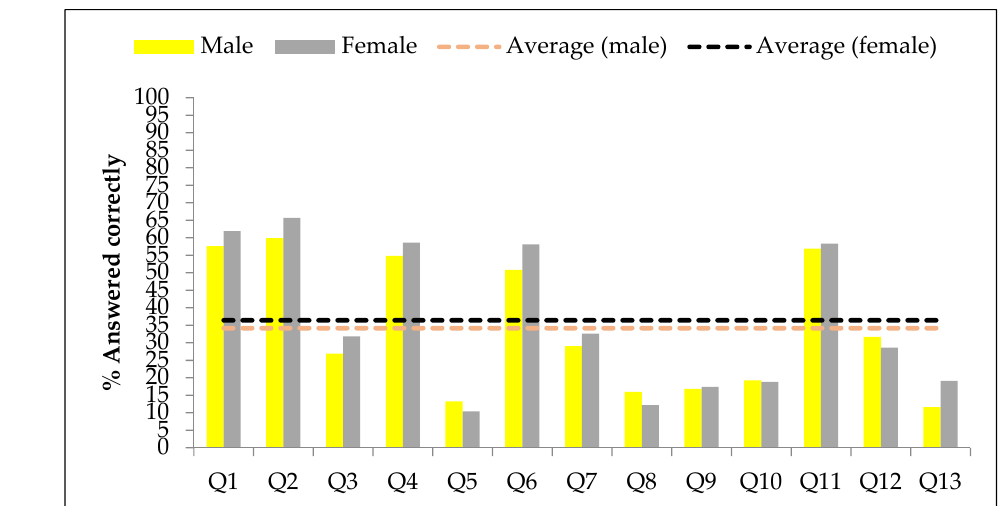
Figure 1. A bar graph depicting the knowledge about benefits of kale consumption among the study participants. The dotted line shows the average in both sexes.